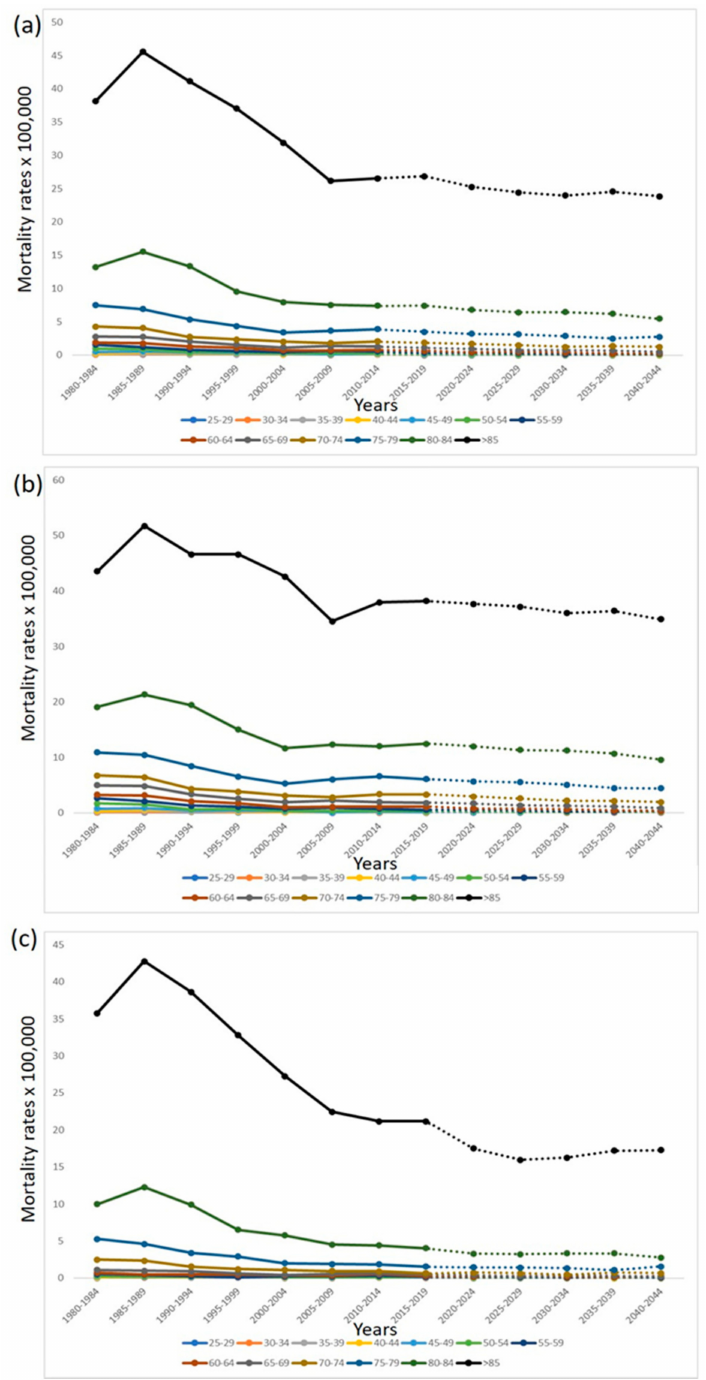
Figure 1. Observed (1980–2019) and predicted (2020–2044) age-specific mortality rates for NMSC in Spain. ( a ) Both sexes; ( b ) males; ( c )